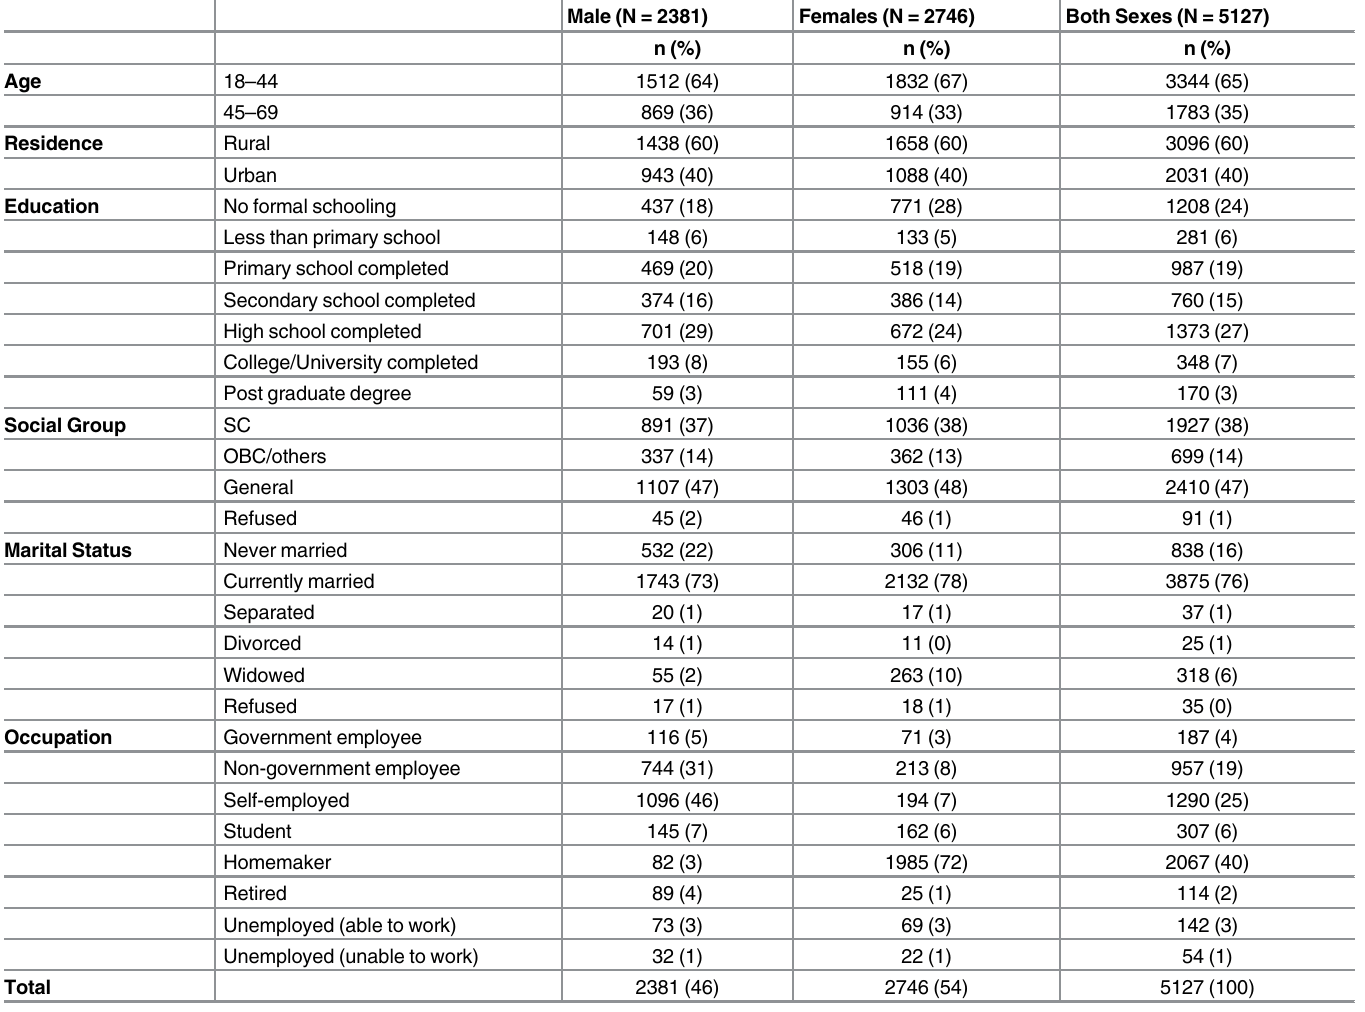
Table 1. Socio-demographic profile of study participants in STEPS Survey, Punjab, India * .